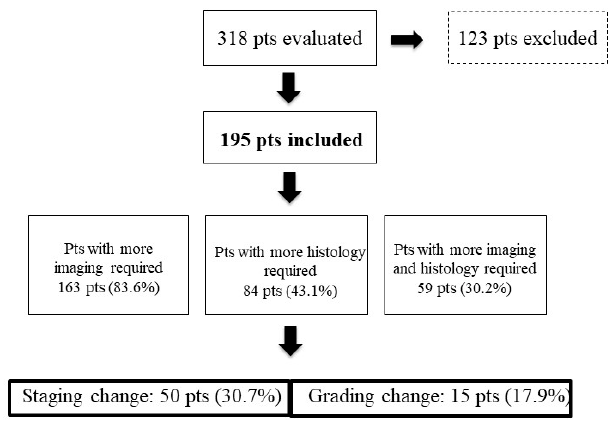
Figure 1. Staging and grading modification after visit at the Center. pts, patients. Table 1. Patients’ general